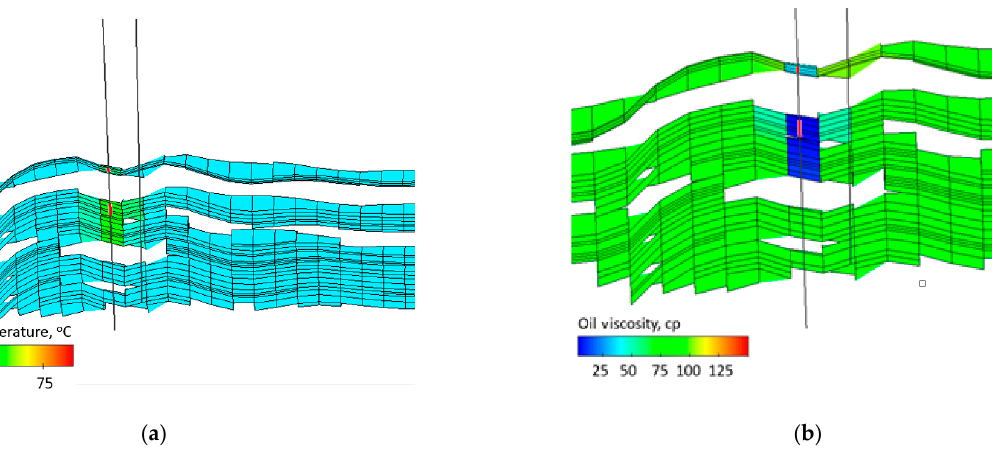
Figure 4. An example of the considered model of an oil reservoir: ( a ) the result of calculating the temperature distribution of the bottomhole formation zone after steam injection; ( b ) the result of calculating the distribution of the dynamic viscosity of oil within the bottomhole formation